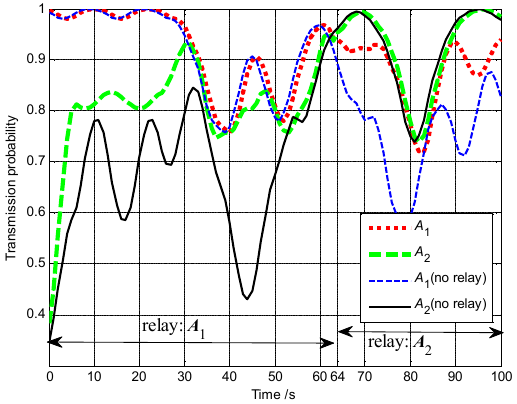
Figure 9. The probabilities of successful transmission of A 1 and A 2 to base station (Group A in Scenario 1).